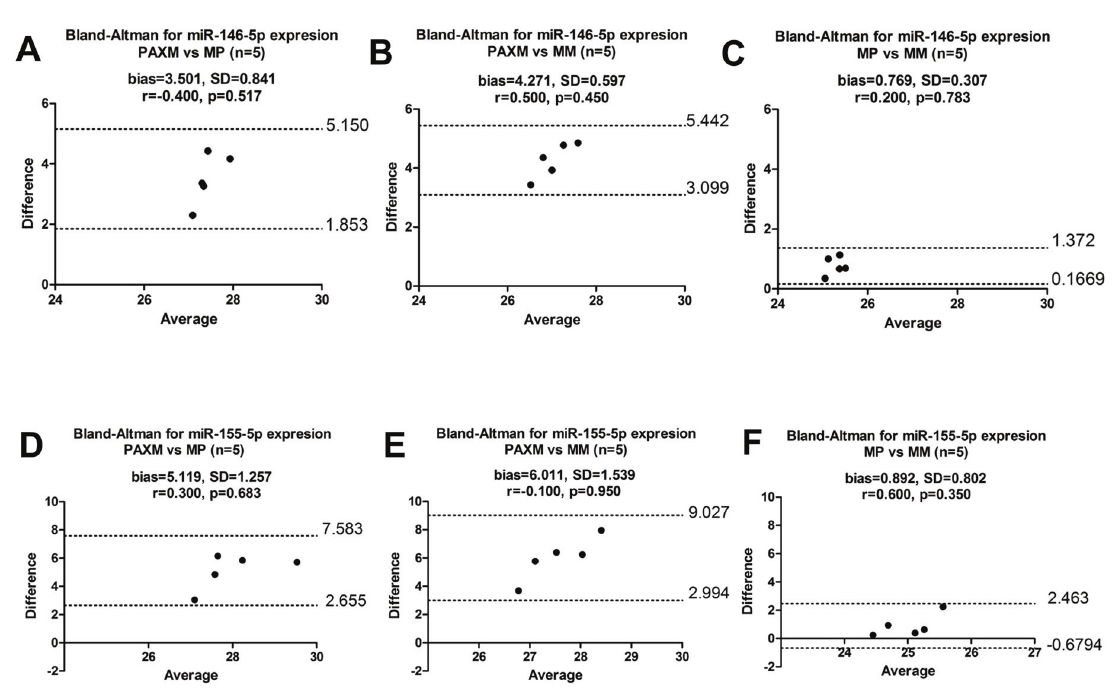
Figure 6. Bland-Altman plots for miR-146a-5p and miR-155-5p expression in whole blood and PBMCs. The three methods were all compared for miR-146a-5p as ( A ) PAXM vs MP ( B ) PAXM vs MM and ( C ) MP vs MM as well as miR-155-5p ( D ) PAXM vs MP ( E ) PAXM vs MM ( F ) MP vs MM. MicroRNA expression is within the limits of agreement but the bias is greater than one showing high disagreement between PAXM and MP. Bias is lower than one for MP and MM, thus the two methods agree with one another. r indicates Spearman correlation. SD: Standard Deviation and bias is the mean difference. C values were used for this analysis. Dashed lines show the 95% lower and upper limits of q